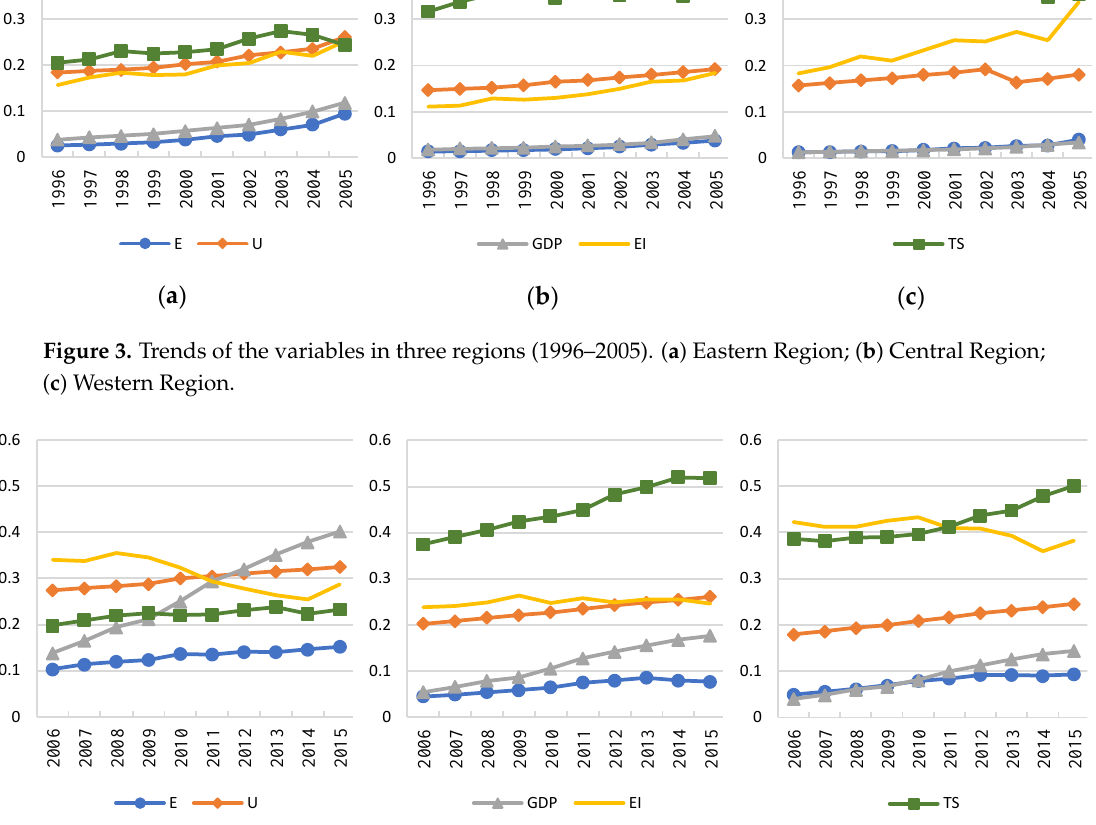
Table 2. Selection results of panel data model (1996-2005). Test Type